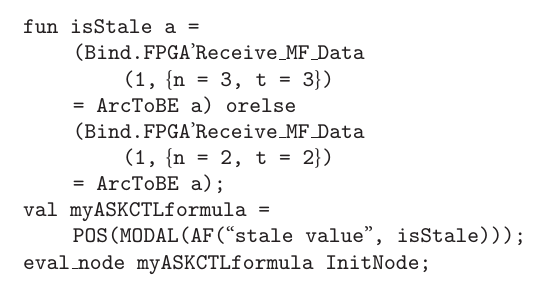
Algorithm 3: Propery formula in SML